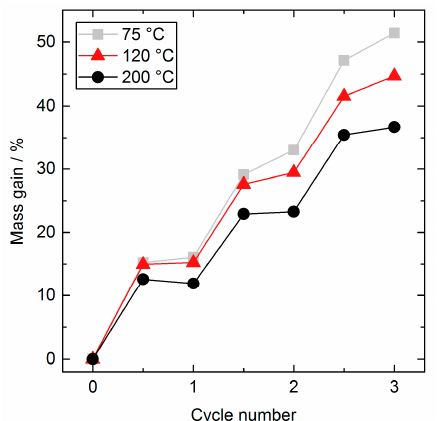
Figure 6. Mass gain over cycle number for AlO x coating on SiO 2 at different temperatures: 200 °C (black, ● ), 120 °C (red, ▲ ), and 75°C (grey, ■ ).